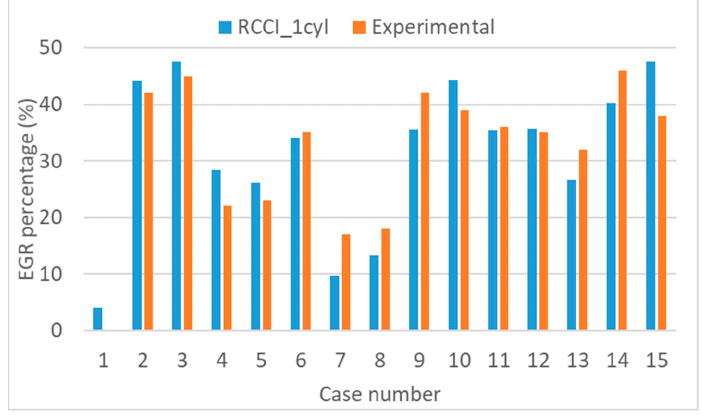
Figure 5. EGR rate comparison between the calibrated 1D model and experimental data.